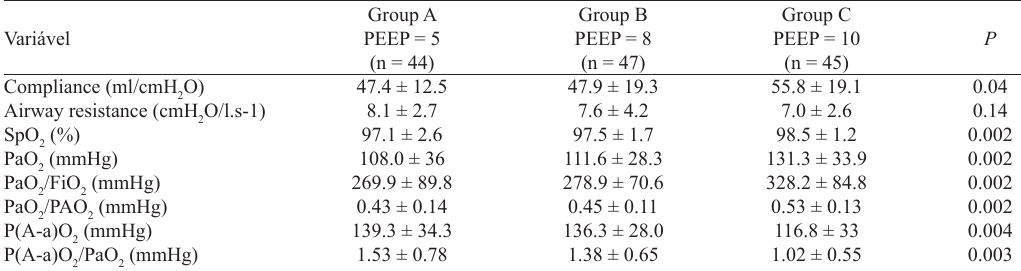
Table 3. PEEP level, respiratory mechanics and oxygenation indices association.